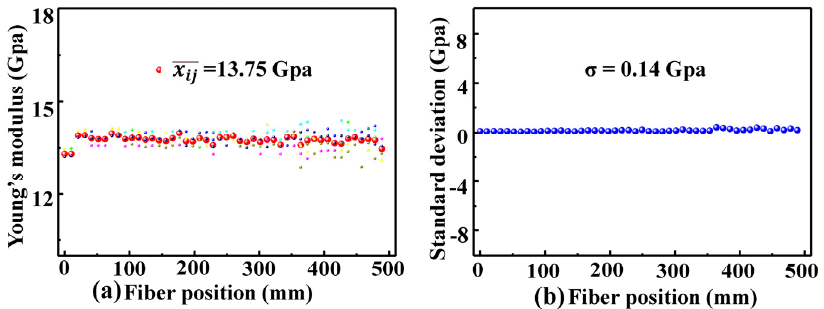
Figure 6. ( a ) Young’s modulus distributions for the measurements taken eight times and their average value distribution ( • ) in the coated SMF sample, ( b ) corresponding standard deviation distribution.